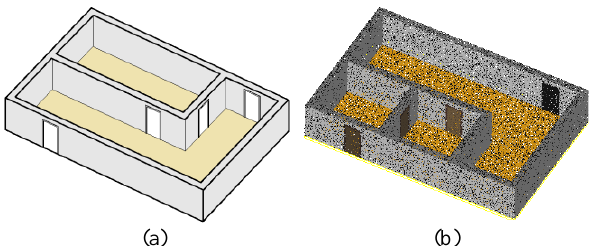
Figure 2. The synthetic dataset: (a) the BIM; (b) the point cloud.